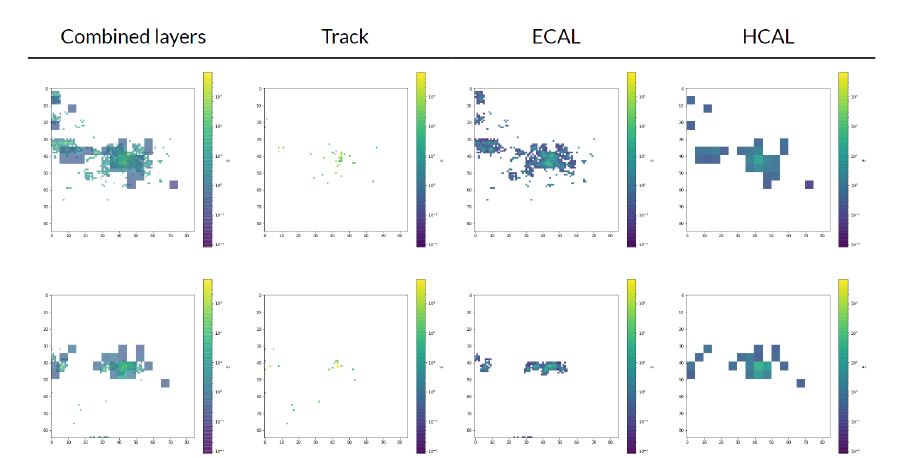
Figure 1. The visualization of the energy deposits in ECAL and HCAL calorimeter layers for two distinct ttbar events (top and bottom). The tracks layer shows the tracks projected to the ECAL surface. The leftmost image is the combined one from all the three